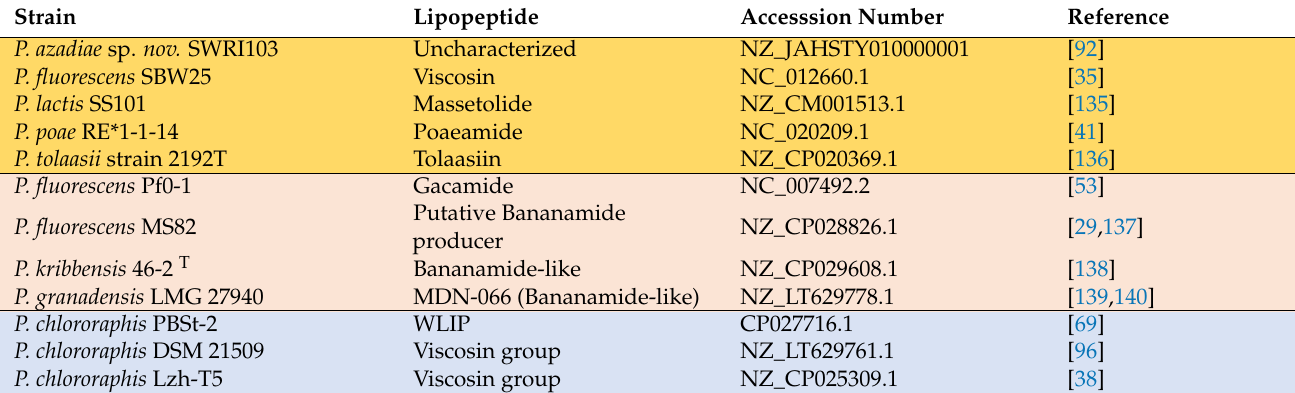
Table A1. Representative Lipopeptide-Producing Pseudomonas Genomes Used to Generate the Com- parative Genome Blast Atlas, with Strains Affiliated to Different Taxonomic Groups and